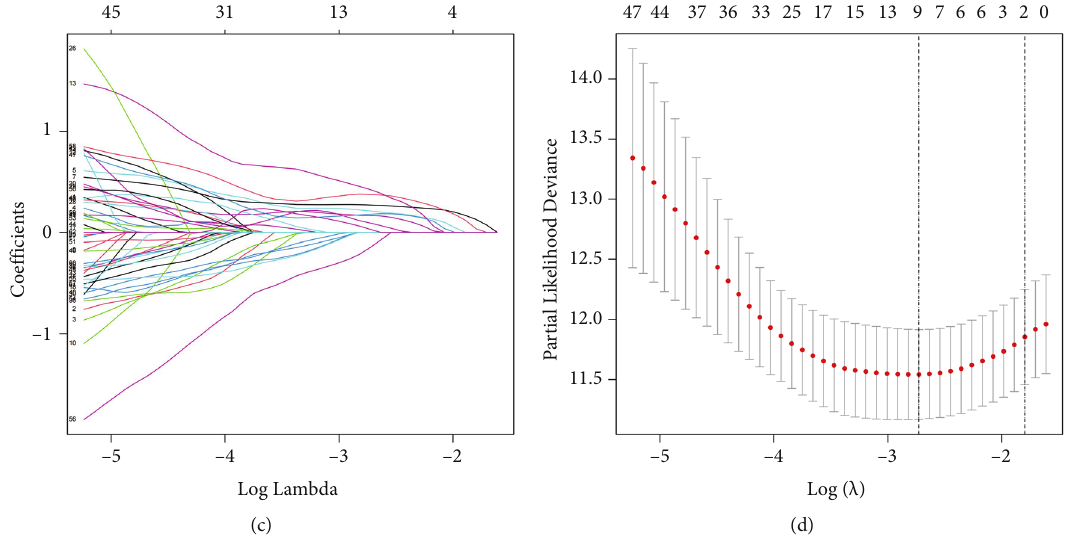
Figure 2: The prognostic model for cuproptosis-related long non-coding ribonucleic acids (lncRNA) signatures. (a) and (b) The heatmap and forest plot of prognosis-related lncRNAs as obtained from uni-Cox analysis. (c) and (d) The Least Absolute Shrinkage and Select Operator regression results for further lncRNA